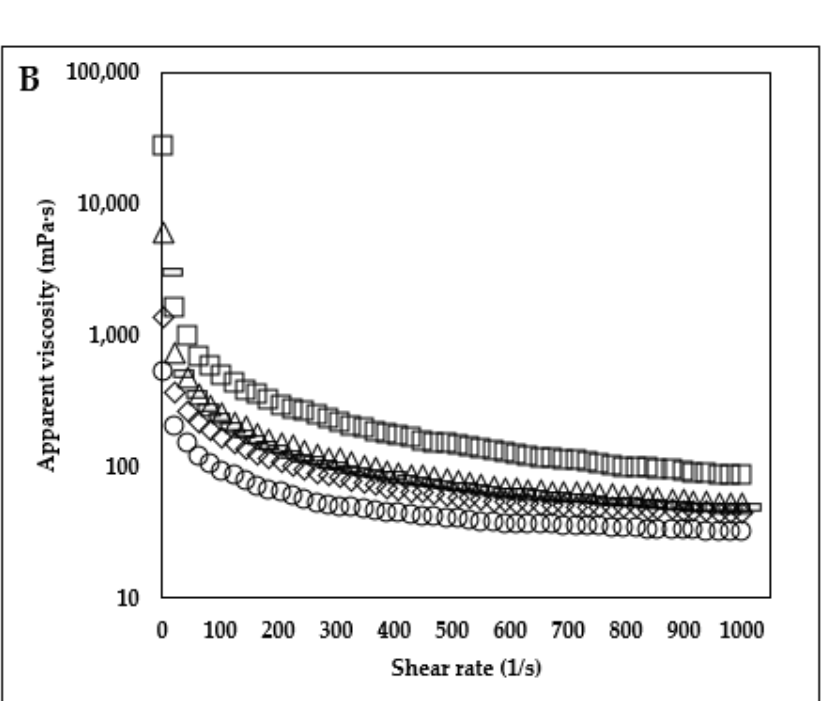
( B ) Figure 2. Frequency sweep test. G’—storage modulus and G”—loss modulus as a function skim milk sample treated with 0.1% (HA + KC) concentration and different ratios of HA: KC. ( A ) HA-control (100:0) G’ ( ▲ ), G” ( ∆ ), HA: KC (85:15) G’ ( ▬ ) G” ( ), ( B ) HA: KC (70:30) G’ ( ♦ ) G” ( ◊ ), HA:KC